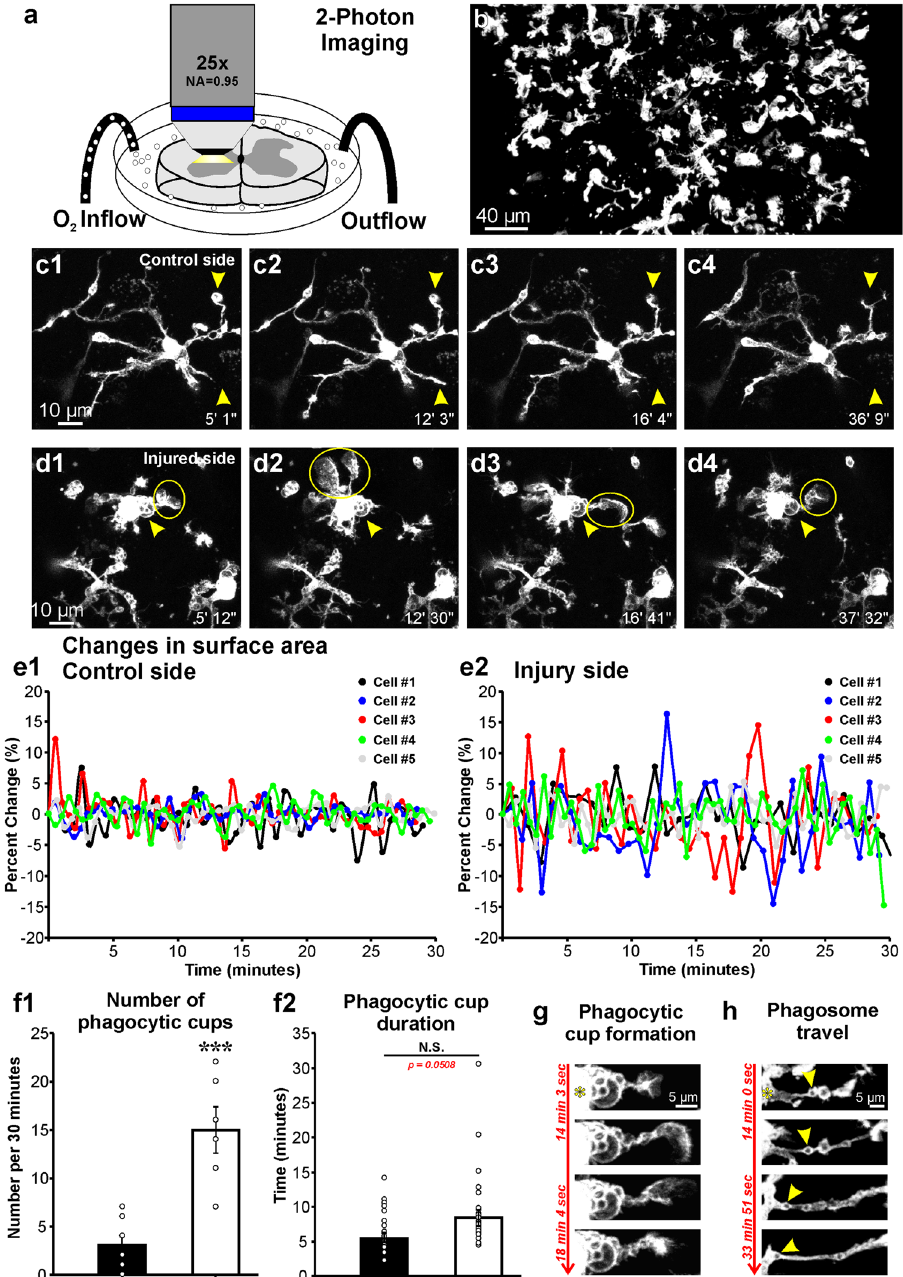
Figure 3. Microglia dynamics in adult spinal cord slices. ( a ) Slices were imaged with a 25X water immersion objective (0.95 NA). To avoid movement artifacts, bath circulation was stopped during imaging. ( b ) Single frame of Supplementary movie 1 showing the whole field of view of a ventral horn containing activated CX3CR1-GFP microglia (white) 3 days after a sciatic nerve cut. ( c1–4, d1–4 ) Individual frames from 45 min time-lapse sequences of microglia contralateral ( c1–4 ) and ipsilateral ( d1–4 ) to the nerve injury (zoom = 3.5 × ). (c1–4 = 1 min 2.6 s between individual frames for a volume depth of 26 µ m, d1–4 = 1 min 0.3 s between individual frames for a volume depth of 25 µ m). Yellow arrowheads show positions of individual processes over time. Microglia ipsilateral to the injury are more active, expanding and contracting processes and forming phagocytic cups (yellow circles). ( c1–4) frames are from Supplemental movie 2 and d1–4 frames from Supplemental movie 3. ( e1–2 ) Changes in surface area (SA) over time (between each frame) in five control ( e1 ) and five activated ( e2 ) microglia. ( f1) Average number of phagocytic cups per cell (n = 8 cells in control, black bars and n = 6 cells 3 days after axotomy, white bars) showed significant differences between control and 3 days after nerve injury ( *** p < 0.001). ( f2 ) Average duration of individual cups formed by control and activated microglia (control: n = 21 cups, cut: n = 25 cups). Cup durations were similar except for a few parent processes in which full retraction were very slow. The difference did not reach significance (p = 0.0508). Error bars =